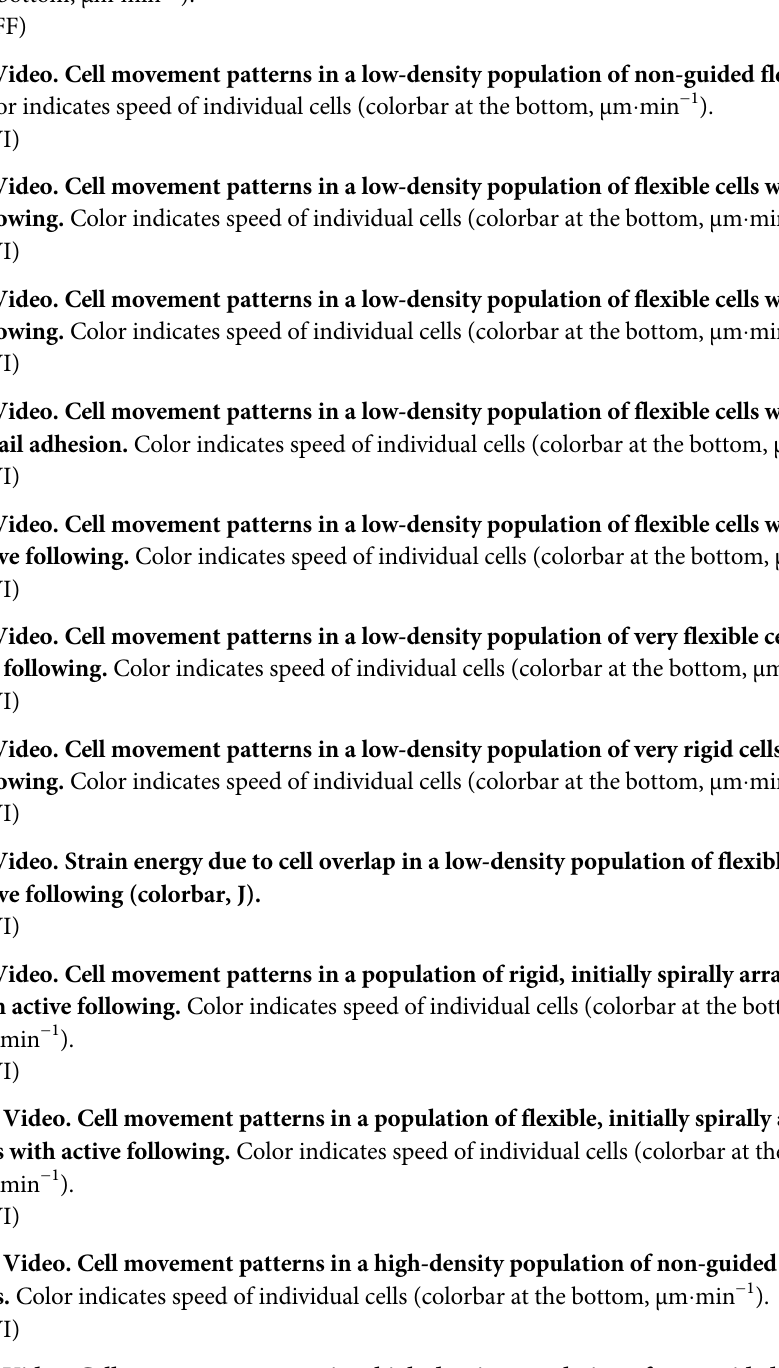
Final configuration of flexible cells at 6 h. Color indicates speed of individual cells (colorbar at the bottom, μ m (cid:2) min − 1 ). (TIFF) S1 Video. Cell movement patterns in a low-density population of non-guided flexible cells. Color indicates speed of individual cells (colorbar at the bottom, μ m (cid:2) min − 1 ). (AVI) S2 Video. Cell movement patterns in a low-density population of flexible cells with passive following. Color indicates speed of individual cells (colorbar at the bottom, μ m (cid:2) min − 1 ). (AVI) S3 Video. Cell movement patterns in a low-density population of flexible cells with active following. Color indicates speed of individual cells (colorbar at the bottom, μ m (cid:2) min − 1 ). (AVI) S4 Video. Cell movement patterns in a low-density population of flexible cells with head- to-tail adhesion. Color indicates speed of individual cells (colorbar at the bottom, μ m (cid:2) min − 1 ). (AVI) S5 Video. Cell movement patterns in a low-density population of flexible cells with weak active following. Color indicates speed of individual cells (colorbar at the bottom, μ m (cid:2) min − 1 ). (AVI) S6 Video. Cell movement patterns in a low-density population of very flexible cells with ac- tive following. Color indicates speed of individual cells (colorbar at the bottom, μ m (cid:2) min − 1 ). (AVI) S7 Video. Cell movement patterns in a low-density population of very rigid cells with active following. Color indicates speed of individual cells (colorbar at the bottom, μ m (cid:2) min − 1 ). (AVI) S8 Video. Strain energy due to cell overlap in a low-density population of flexible cells with active following (colorbar, J). (AVI) S9 Video. Cell movement patterns in a population of rigid, initially spirally arranged cells with active following. Color indicates speed of individual cells (colorbar at the bottom, μ m (cid:2) min − 1 ). (AVI) S10 Video. Cell movement patterns in a population of flexible, initially spirally arranged cells with active following. Color indicates speed of individual cells (colorbar at the bottom, μ m (cid:2) min − 1 ). (AVI) S11 Video. Cell movement patterns in a high-density population of non-guided flexible cells. Color indicates speed of individual cells (colorbar at the bottom, μ m (cid:2) min − 1 ). (AVI) S12 Video. Cell movement patterns in a high-density population of non-guided very rigid cells. Color indicates speed of individual cells (colorbar at the bottom, μ m (cid:2) min − 1 ).